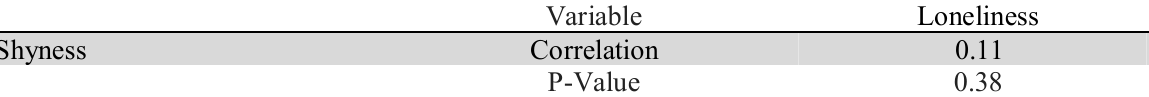
The summary of Pearson correlation